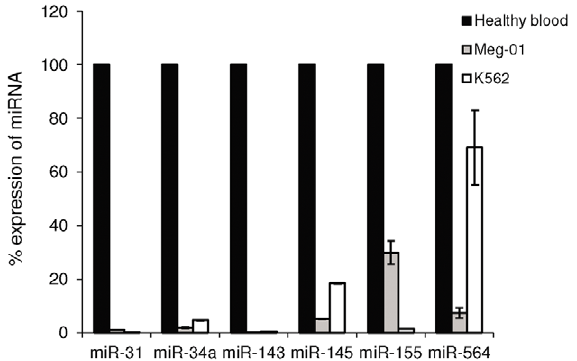
Figure 3. Expression analysis of miRNAs in CML-derived cell lines as compared to a pooled sample of healthy blood. Expression analysis of miR-31, miR-34a, miR-143, miR-145, miR-155 and miR-564 in Meg-01 and K562 cell lines and in healthy blood samples was analyzed by miR–qRT-PCR. Shown is the percentage of miRNA expression normalized to U6-snRNA 6 SEM from at least 3 experiments.